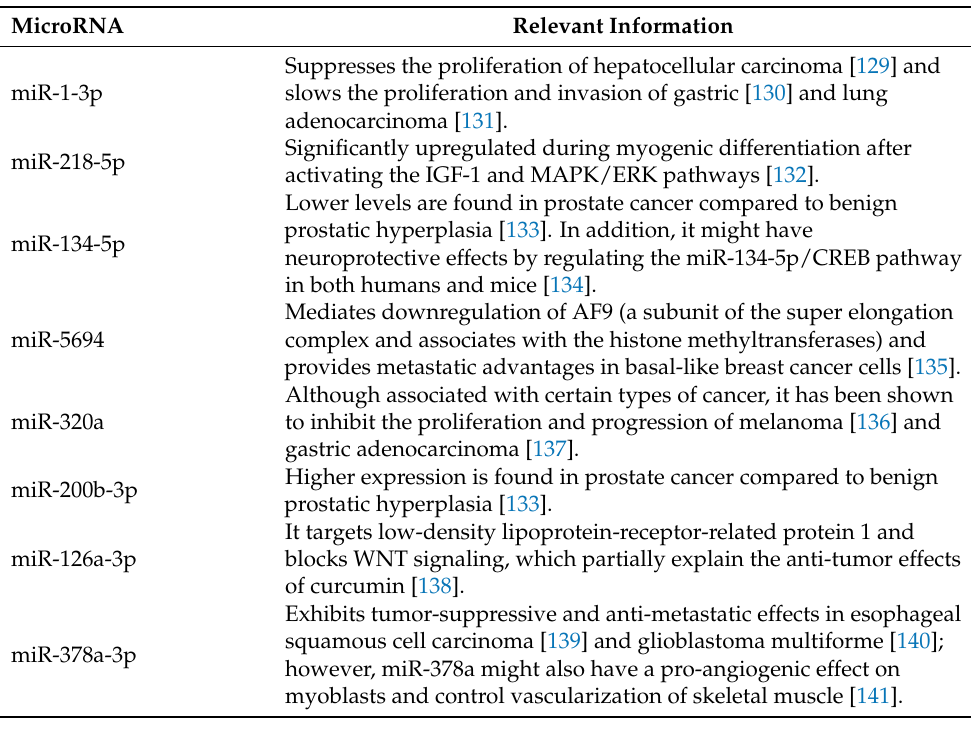
Table 3. Information of predicted miRNAs interacting with the list of genes from the CFG